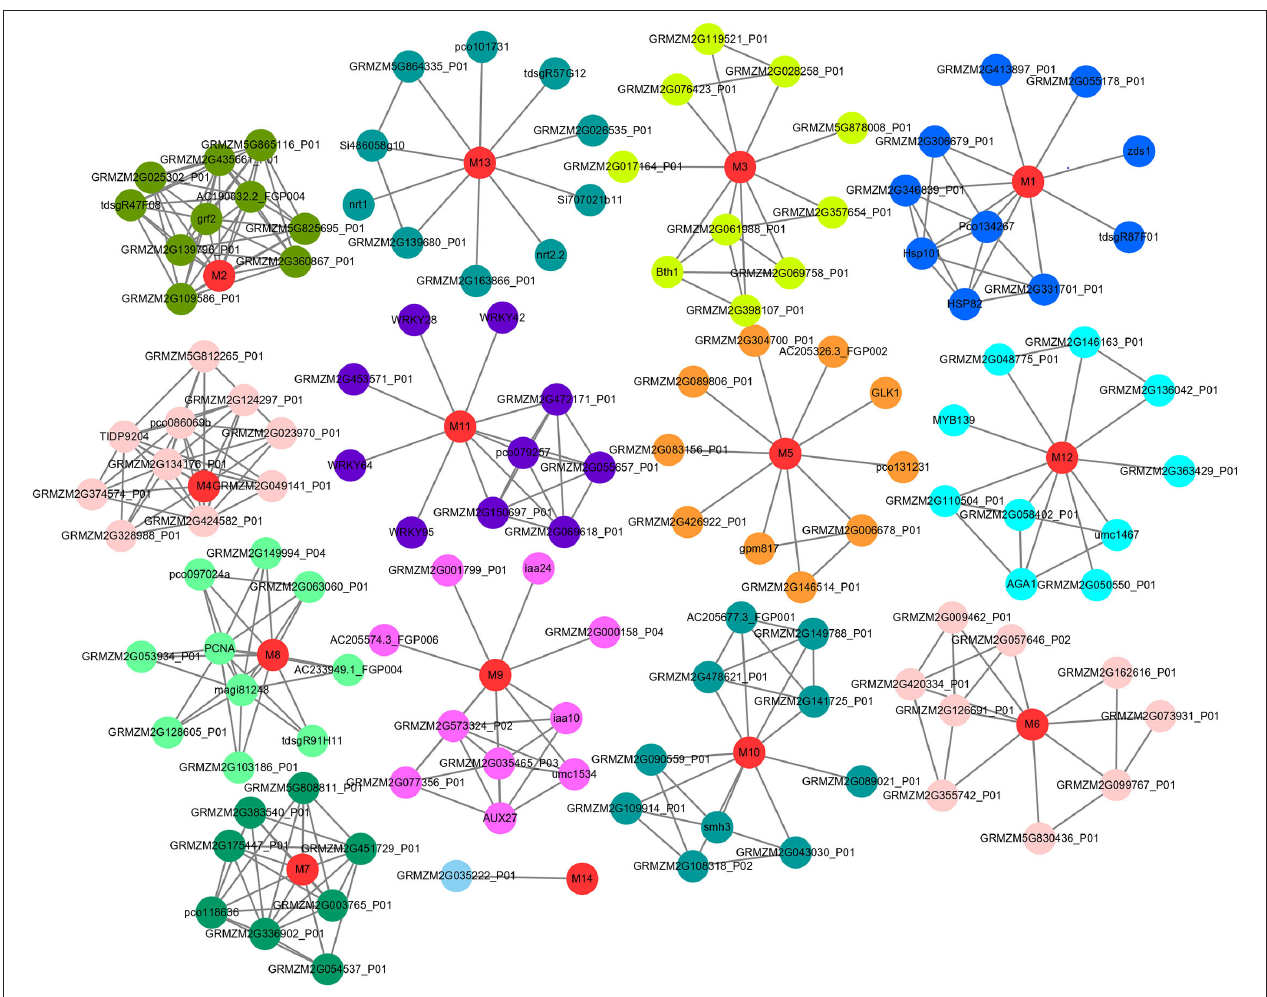
FIGURE 4 | Protein-protein interaction networks of 14 candidate genes. The nodes indicate proteins, and the lines indicate the interaction between proteins. Red color indicates candidate genes encoded proteins, and the interactive proteins in different networks are distinguished by different colors. M1-M14 are the candidate genes encoded